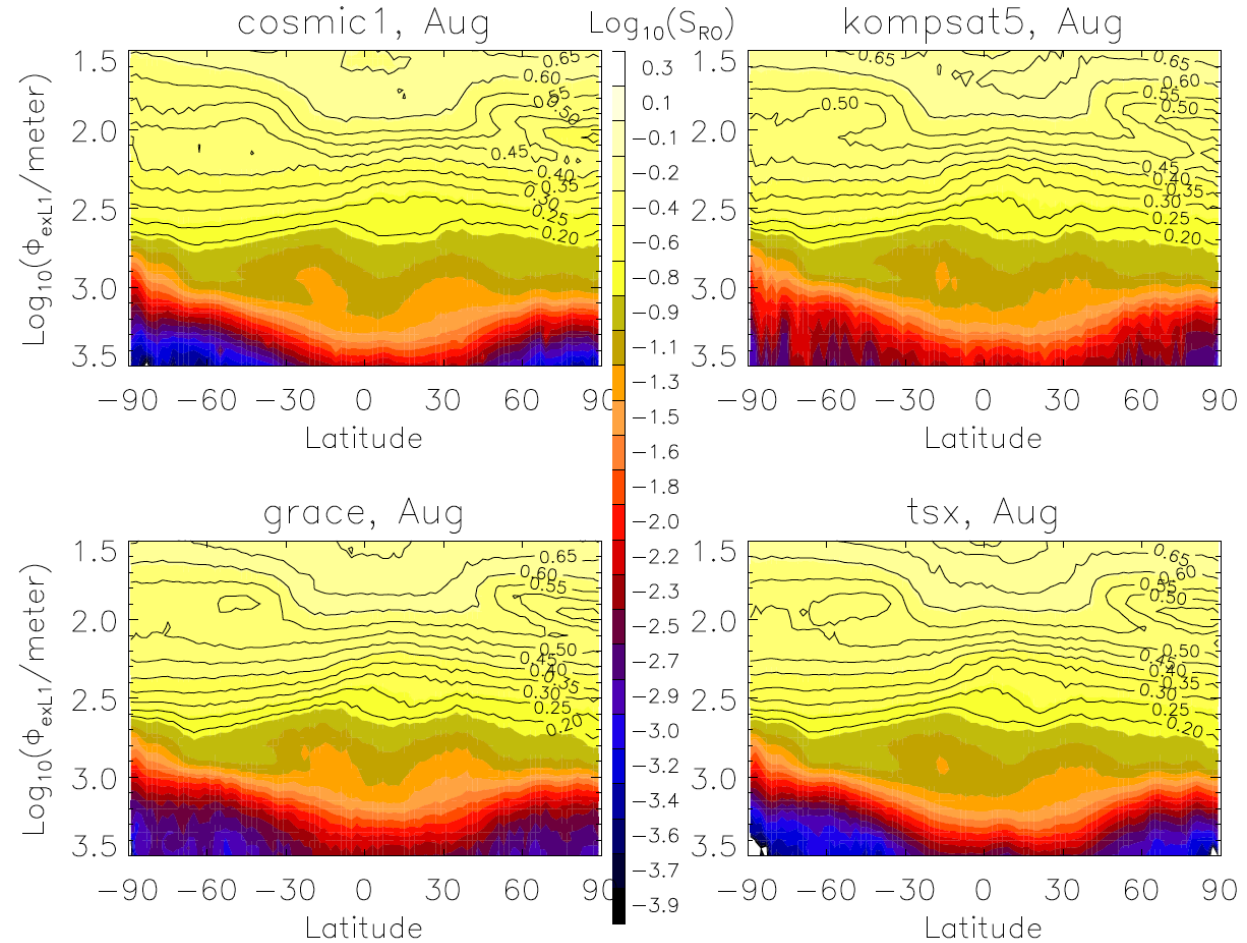
Figure 7. As in Figure 6 but for S RO as a function of Log 10 ( 𝜙 exL1